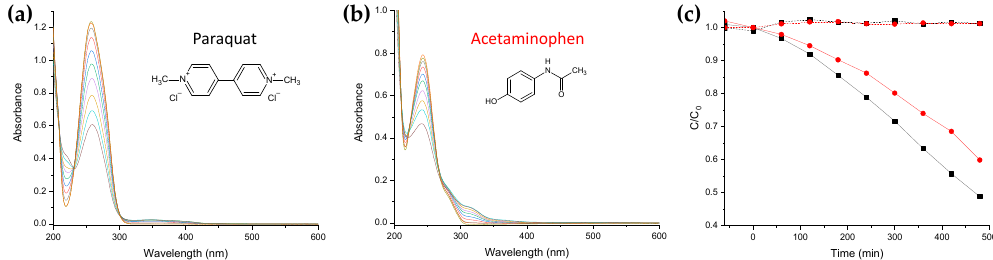
Figure 5. UV–vis spectra acquired during Paraquat ( a ) and Acetaminophen ( b ) photodegradation, with the related molecular structures. ( c ) Variations of Paraquat (Black) and Acetaminophen (Red) concentration ratio (C/C 0 ) in function of the irradiation time in the presence of the thin films of NC1. The dashed lines represent the related photolysis.